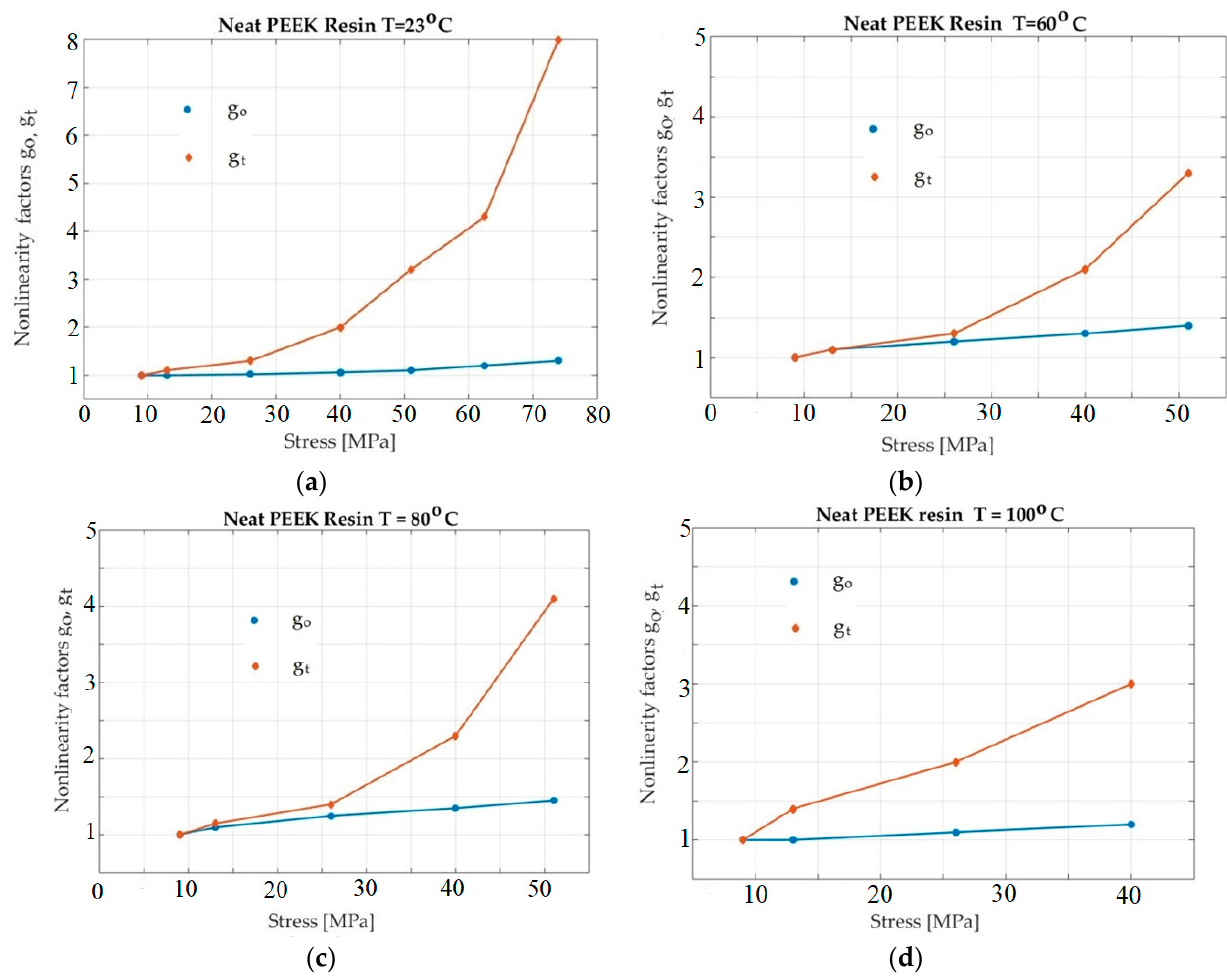
Figure 6. Plot of g o and g t for the neat PEEK as a function of stress and temperature: ( a )—T = 23 °C; ( b )—T = 80 °C; ( c )—T = 120 °C; ( d )—T = 140 °C.